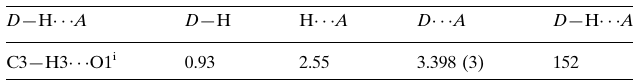
Hydrogen-bond geometry (A˚ , (cid:1) ). D —H (cid:2)(cid:2)(cid:2)